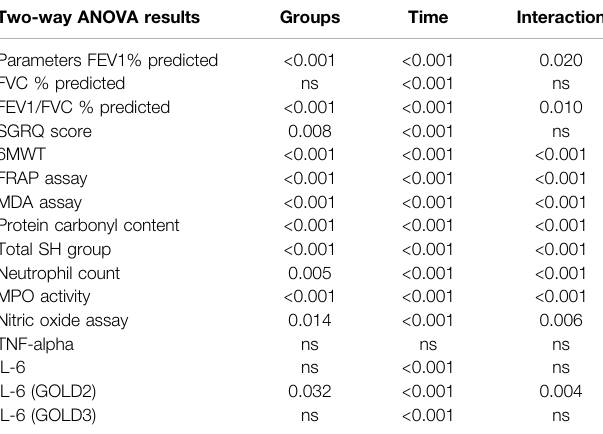
TABLE 1 | Two-way ANOVA results of all the clinical parameters evaluated. Two-way ANOVA results Groups